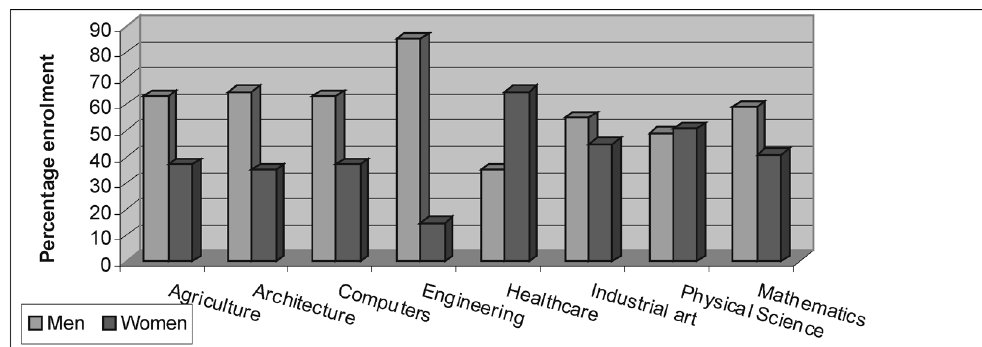
Gender skills enrolment in various fields in South